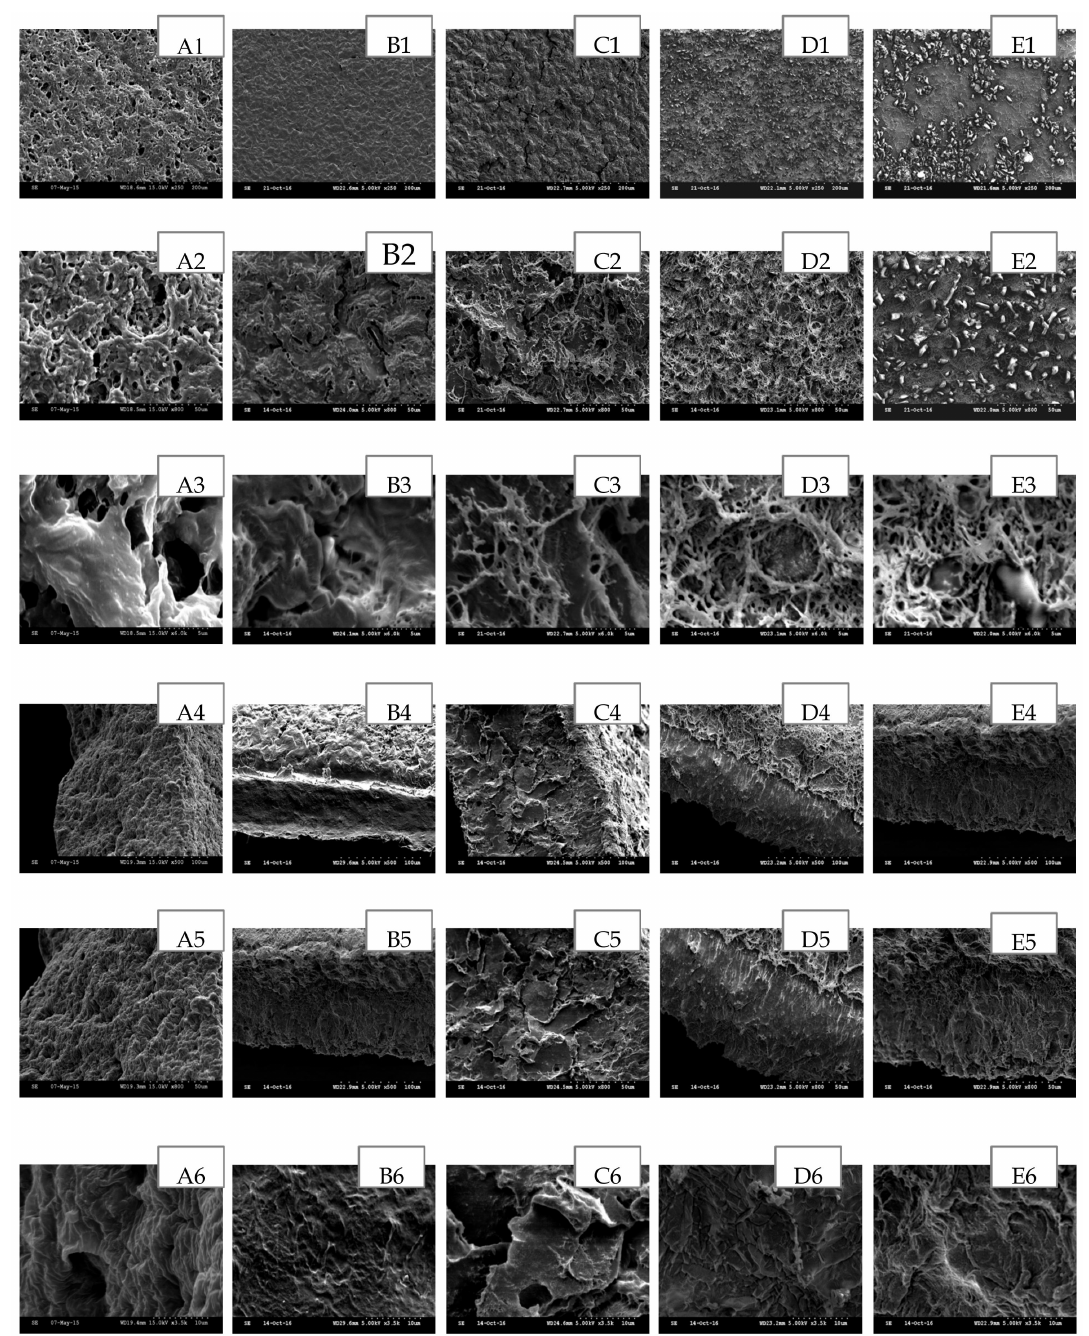
Figure 4. SEM images of post-loaded IBU hydrogel network in comparison to unmedicated hydrogel cross-linked with 5% w / w PETRA. ( A ) Unmedicated PEO, ( B ) PEO-IBU 15.44% w / w (25% saturation), ( C ) PEO-IBU 31.01% w / w (50% saturation), ( D ) PEO-IBU 45.48% w / w (75% saturation), ( E ) PEO-IBU 59.09% w / w (100% saturation). Scale bars are 200, 50 and 5 µ m for micrographs featuring the outer surface of hydrogel network (1–3), 100, 50, and 10 µ m for micrographs featuring the cross section of hydrogel network